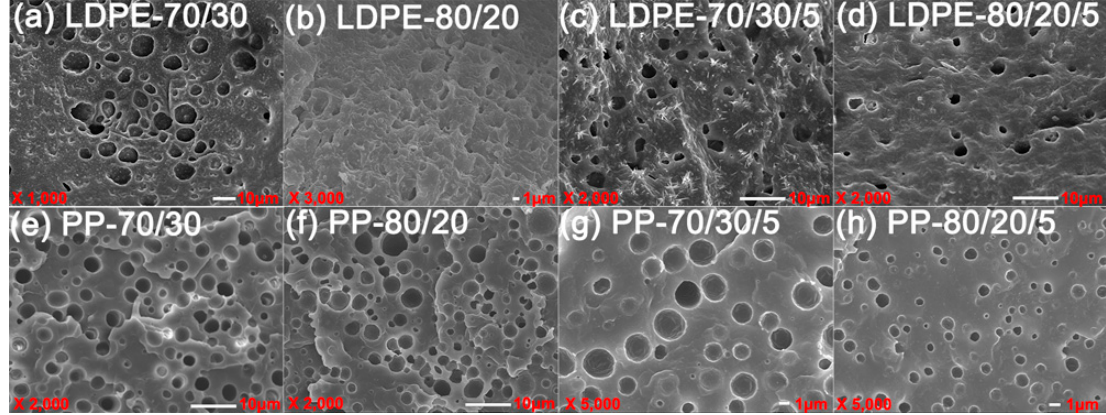
Figure 8. SEM micrographs of incompatible ( a , b , e , f ) and compatibilized ( c , d , g , h ) polymer